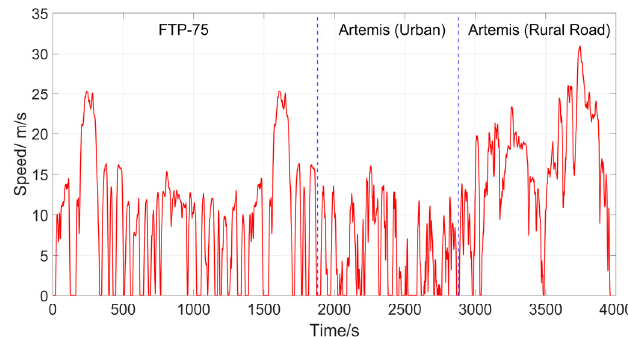
Figure 3. Compound driving cycle.